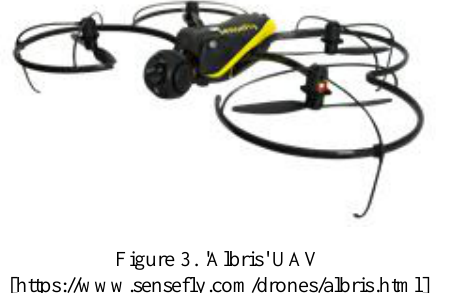
Figure 3. 'Albris' UAV